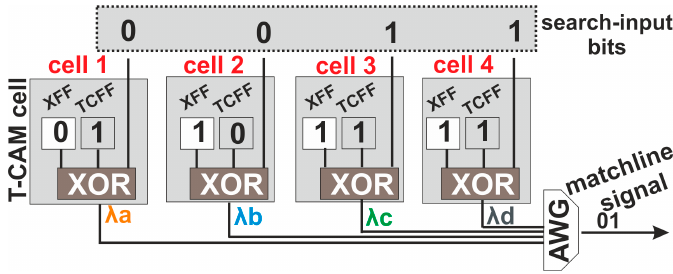
Figure 8. T-CAM row architecture comprising an indicative number of four T-CAM cells.